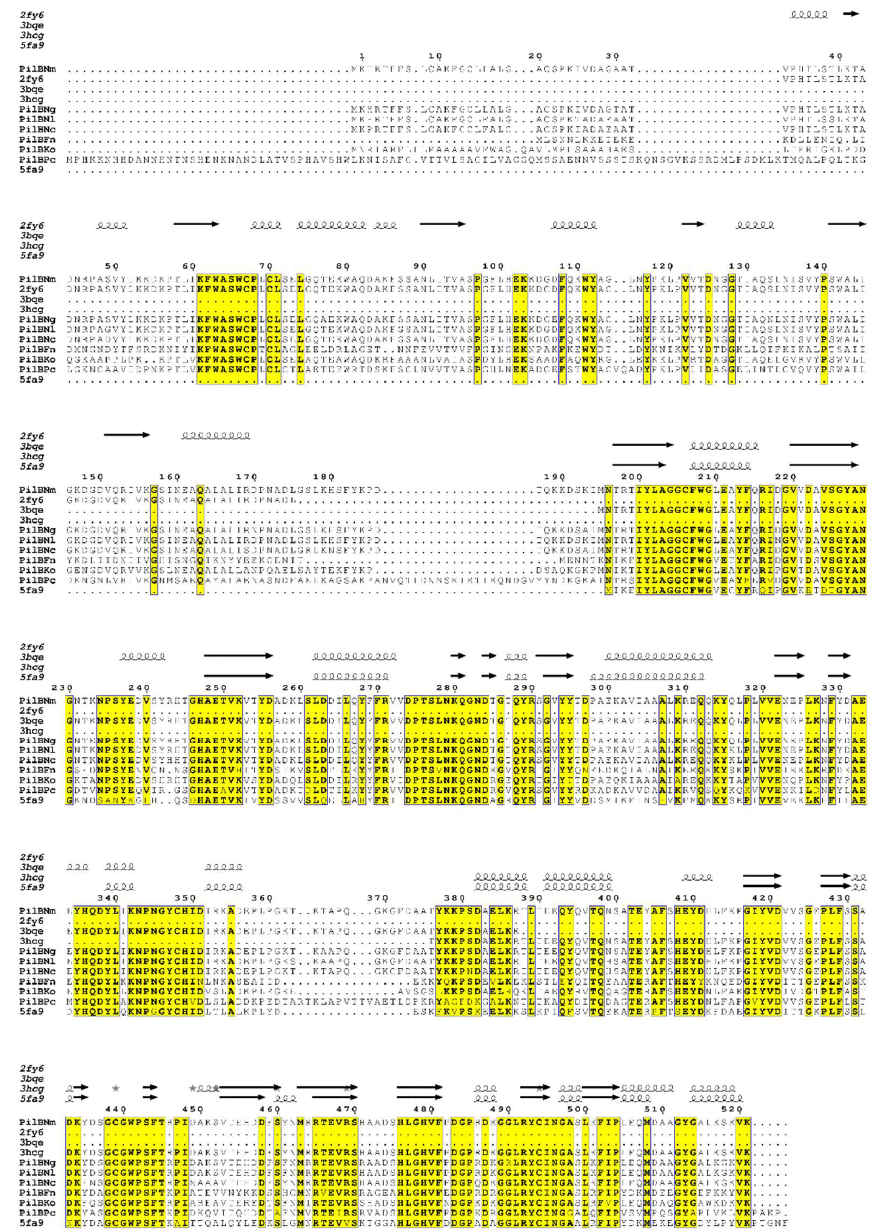
Figure 1. Multiple-sequence alignment of PilB homologues in N. meningitidis (PilBNm), N. gonorrhoeae (PilBNg), N. lactamica (PilBNl), N. cinerae (PilBNc), Fusobacterium nucleatum (PilBFn), Kingella oralis (PilBKo) and Psychrobacter cryohalolentis (PilBPc) and secondary structures of N. meningitidis N -ter (2fy6), MSRA (3bqe) and MSRB (3hcg) domains. MSRAB fusion of Treponema denticola (5fa9) is also presented. The amino acid numbering is based on N. meningitidis PilB. Conserved residues at 80% are indicated in black on yellow boxes. Stars indicate residues with alternate conformations. The linker regions between N -ter and MSRA, and MSRA and MsrB are located between residues 176 and 195, and 357 and 382, respectively. The alignment was carried out using ClustalW [6], and the figure